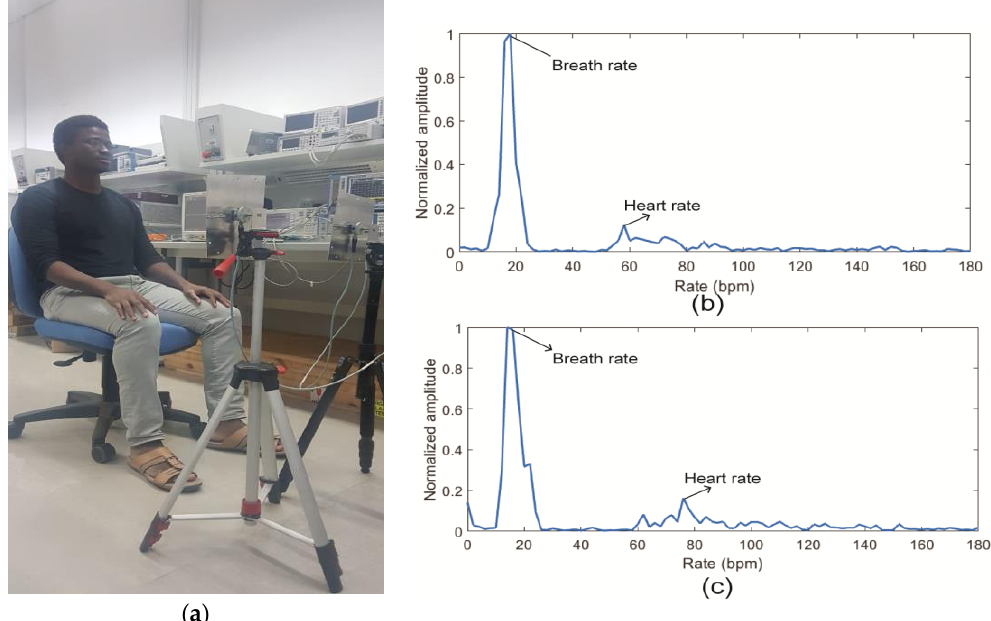
Figure 21. ( a ) Setup of the vector network analyzer (VNA)-based continuous-wave (CW) radar for vital signs measurement; BR and heart rate (HR) of ( b ) Male volunteer and ( c ) female volunteer.